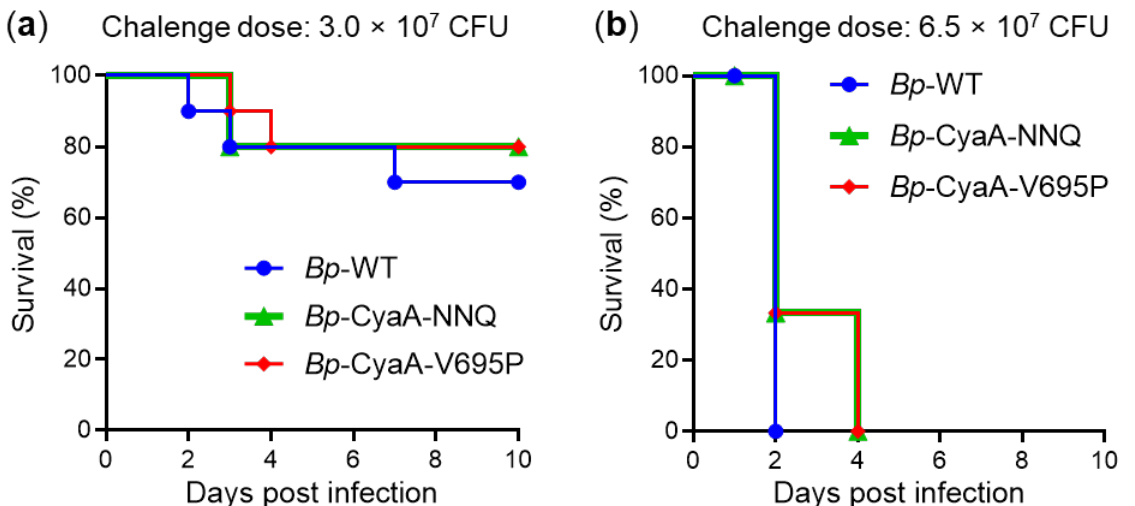
Figure 2. Selective enhancement of the pore-forming activity of CyaA has no impact on the lethality of B. pertussis infection. Survival rates of five-week-old BALB/cByJ mice infected with 3.0 × 10 7 CFU ( a ) or with 6.5 × 10 7 CFU ( b ) of the WT and mutant B. pertussis strains. Mice survival was monitored for 10 days following infection and percentage survival values were calculated using 10 ( a ) or 6 ( b ) mice per challenged group. One representative experiment out of two performed is shown. No significant differences were observed among the survival curves within each challenge group (ANOVA).